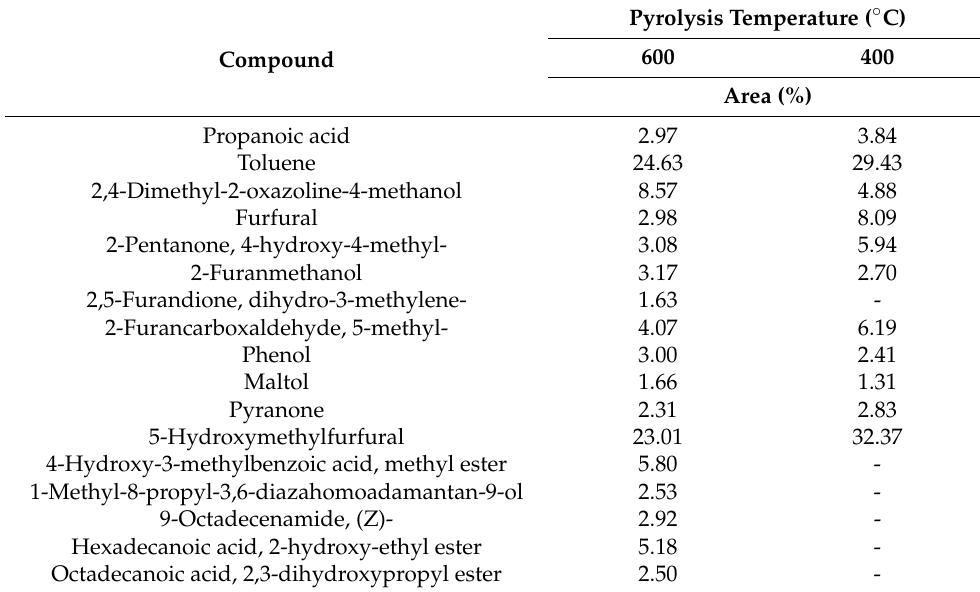
Table 4. Compounds detected in bio-oils chromatograms and their relative area percentages obtained in the pyrolysis of orange waste at different